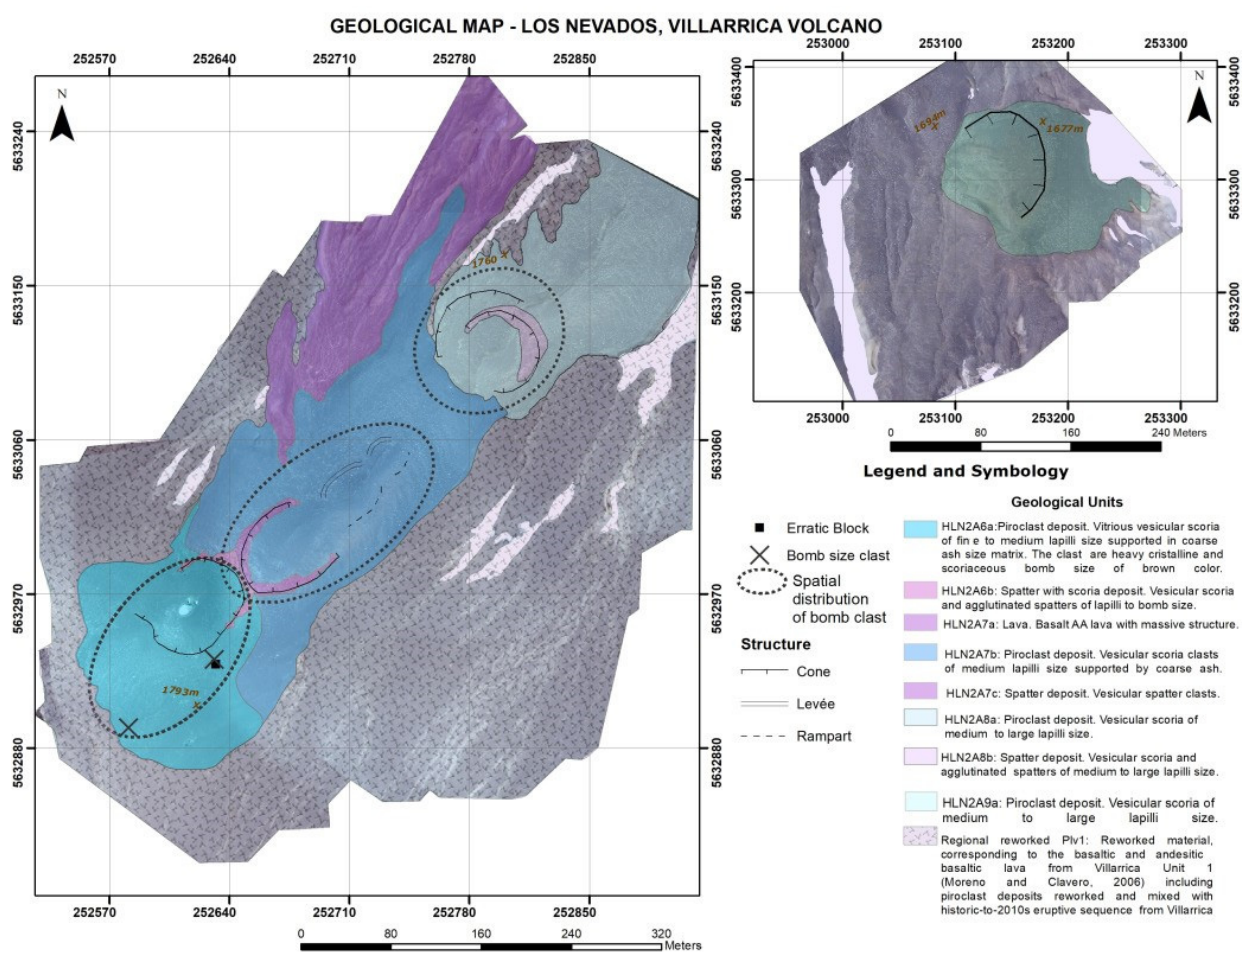
Figure 2. Digital elevation model of Los Nevados Subgroup 2. Sector at the highest topographical levels of Los Nevados Subgroup 2 (see Legend). The semi-transparent polygons represent the new lithological contacts between each eruptive center classified between HLN2A6 to HLN2A8. Topographic isoline separated by 2 m were used. Key altitudes points are indicated for lowest and highest sectors. The sector at the top-right corner represents the lowest topographical levels of eruptive vents from the sector, including HLN2A9 volcanic vent.